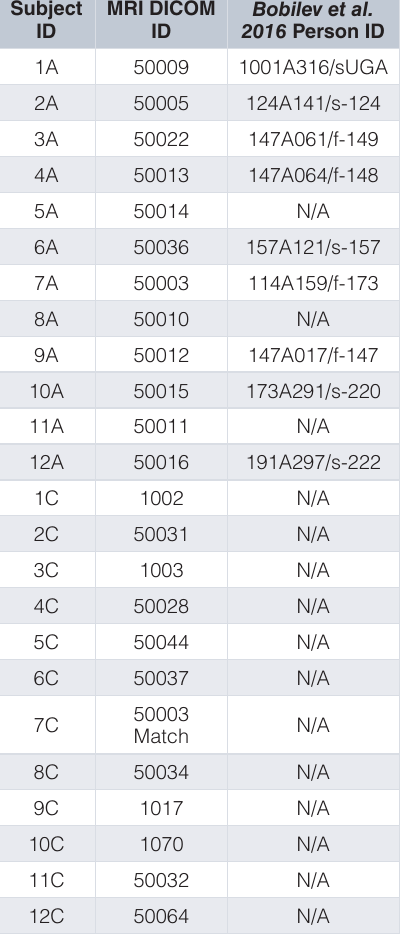
Supplementary Figure 1: Corpus Callosum Cross-sectional area and brain volume comparisons. ( A ) Representation of manually traced corpus callosum in a mid-sagittal slice. ( B ) Corpus callosum area. ( C ) Grey matter volume. ( D ) White matter volume. ( E ) Total brain volume. ( F ) Ratio of corpus callosum area to total brain volume. Line in each graph represents average of group. No statistically significant differences were observed for any of the measurements depicted in this figure (p < 0.05). Click here to access the